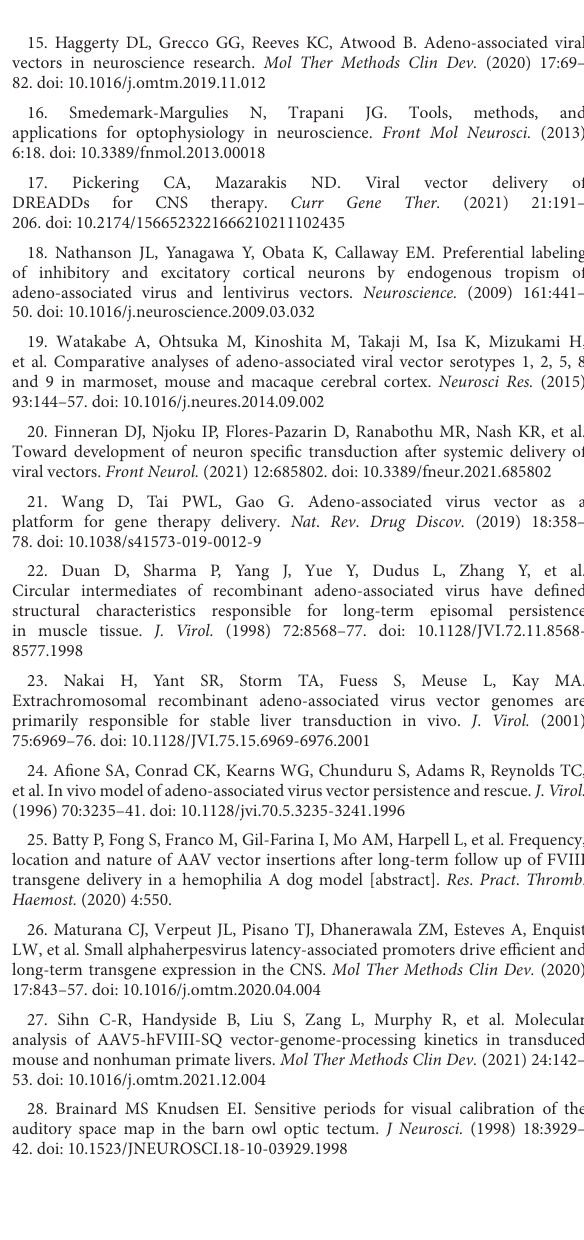
SUPPLEMENTARYFIGURE3 Diagram depicting the circular AAV genome quantification assay. Accurate measurement of AAV genomes within the context of an AAV genome population that is mostly circular requires ECORI digestion. For PSDNASE only digested samples, a concatemer with multiple AAV genomes will count for the same number of positive droplets as a monomer as ddPCR only measures the end point of the PCR reaction. However, the addition of a restriction enzyme digests concatemers into multiple linear AAV genomes, thereby increasing the positive droplets to the corresponding number of AAV genomes released from a concatemer. Created using images from